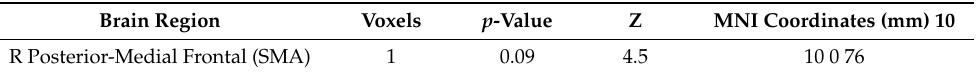
Table 1. Activation of supplementary motor area (SMA): Activations for the identity × phase interaction (OTHER / SELF vs. PRE /